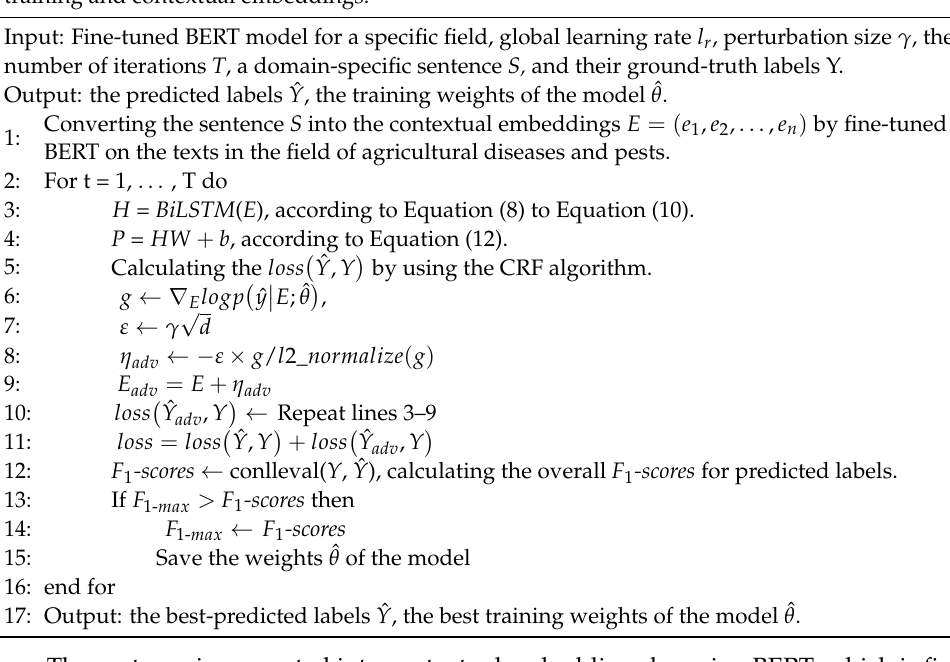
Algorithm A1 Pseudocode for domain-specific named entity recognition task with adversarial training and contextual